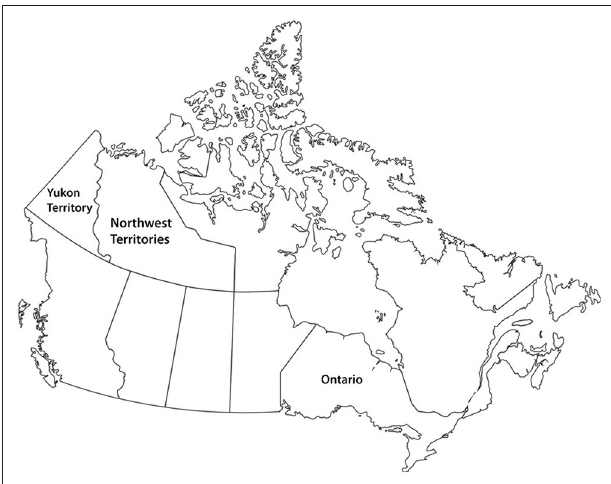
FIGURE 1 | Map of Canada with provincial/territorial jurisdictions included in